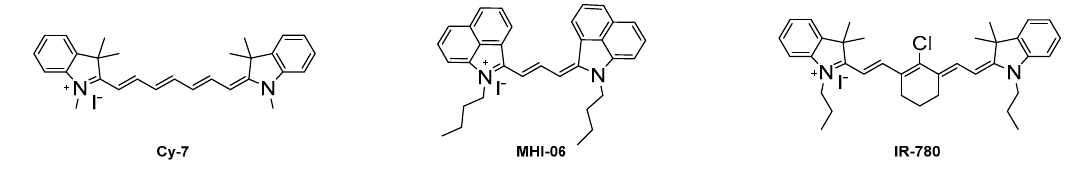
Figure 1. The structures of the three NIR standards used for the study.